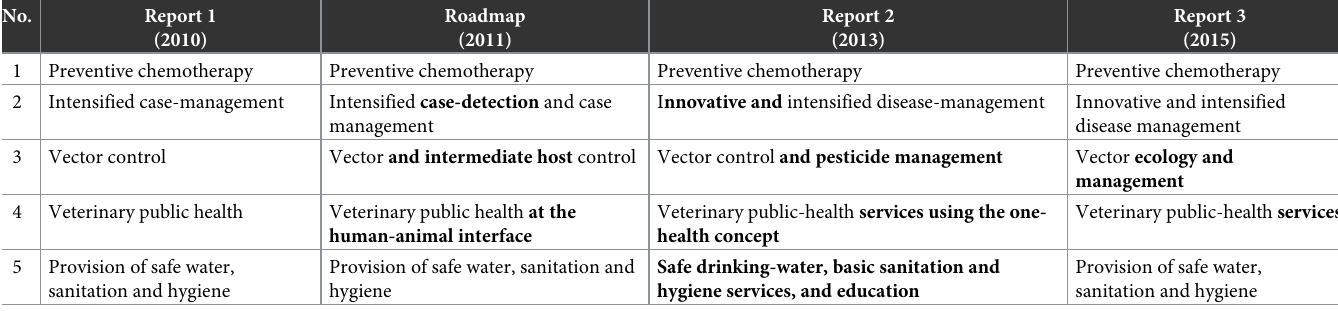
Table 2. Priority Interventions for NTDs as Documented in the WHO Roadmap and Reports.